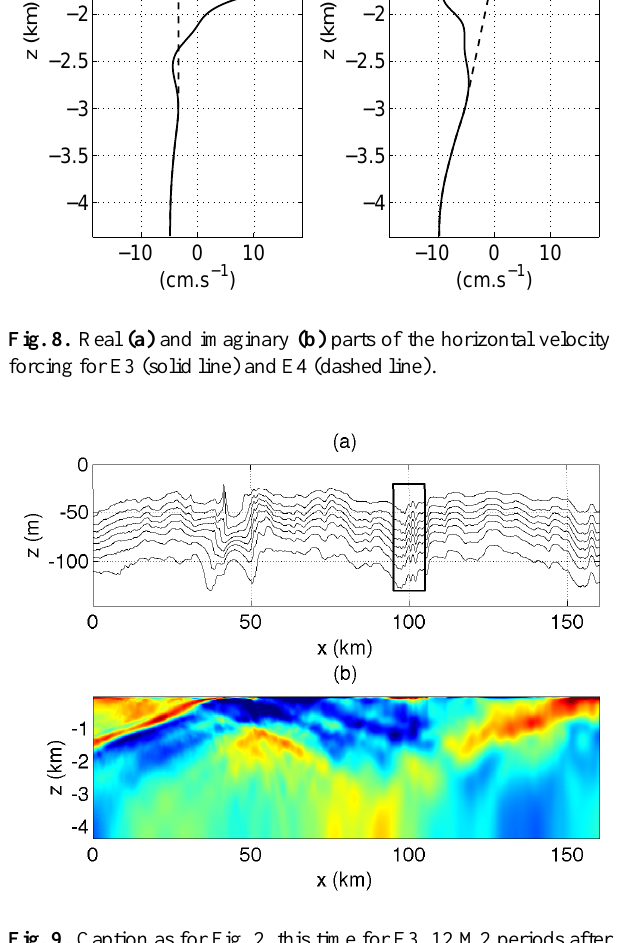
Fig. 9. Caption as for Fig. 2, this time for E3, 12 M2 periods after the start of the